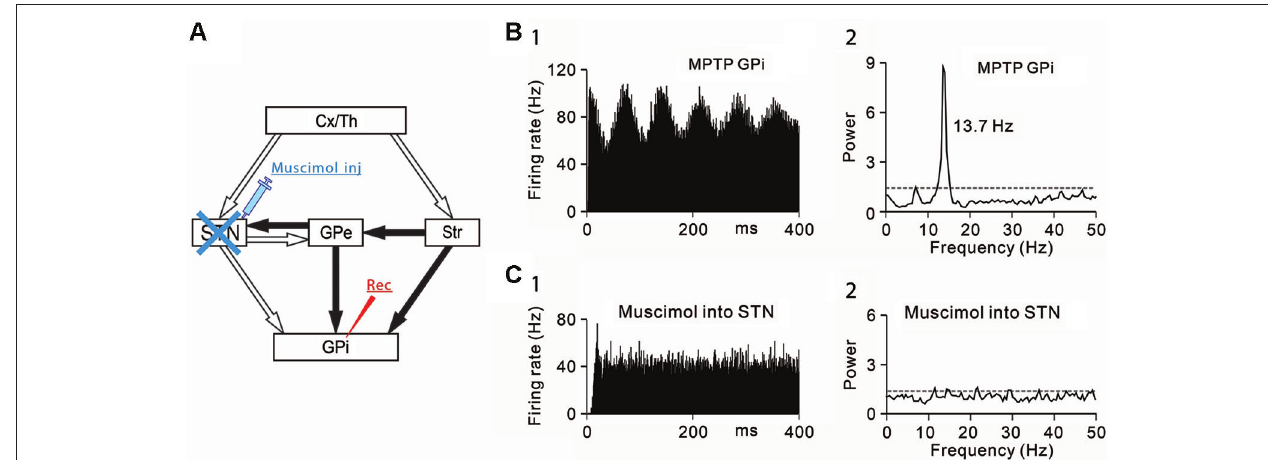
of the globus pallidus; Str, striatum; Th, thalamus. (B) A representative GPi neuron showing abnormal oscillations in the parkinsonian state. (1) Autocorrelograms calculated from a 50-s spike train and (2) power spectra of the same spike trains are shown. Gray dashed lines represent a confidence level of P = 0.01. (C) Muscimol inactivation of the STN decreased the firing rate and 8–15 Hz oscillatory activity of the GPi neuron. Modified from Tachibana et al.